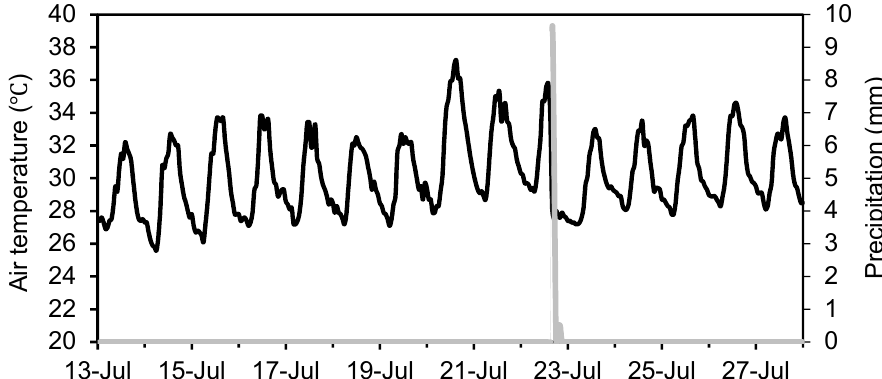
Figure 3. Precipitation (mm) and air temperature (°C) records at Hakata Meteorological Station between 13 July 2018 and 27 July 2018. Black and gray lines represent air temperature and precipitation, respectively.